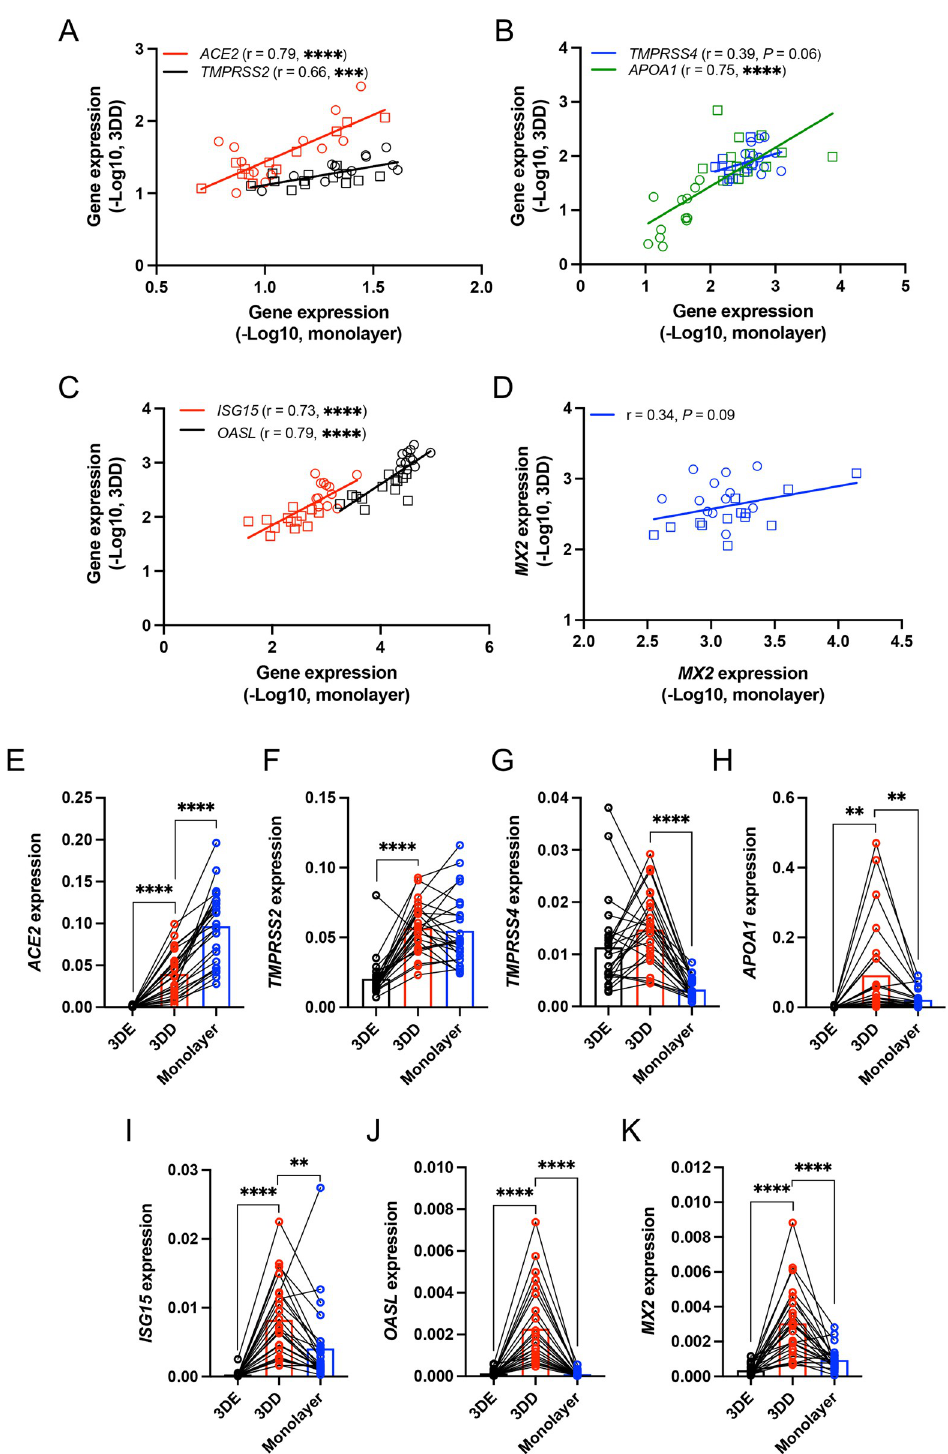
Fig 1. Heterogeneous gene expression patterns in small intestinal and colonic organoids. (A–D) Correlation analysis of ACE2 and TMPRSS2 (A), TMPRSS4 and APOA1 (B), ISG15 and OASL (C), or MX2 (D) expression in human intestinal (circle) and colonic (rectangle) organoids cultured as monolayers grown in differentiation media for 7 days with those cultured as human 3D organoids grown in differentiation media (3DD) for 7 days. (E–K) RT-PCR data comparing ACE2 (E), TMPRSS2 (F), TMPRSS4 (G), APOA1 (H), ISG15 (I), OASL (J), and MX2 (K) expression in